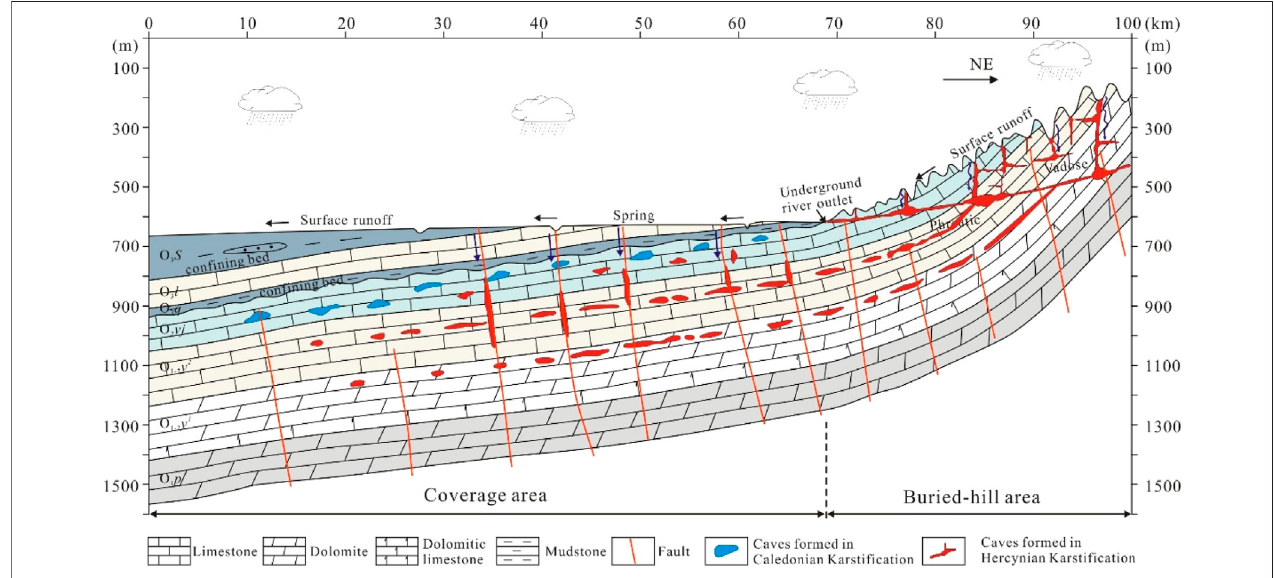
FIGURE 13 | Meteoric water karsti fi cation model in nonexposed limestone of Tahe area.